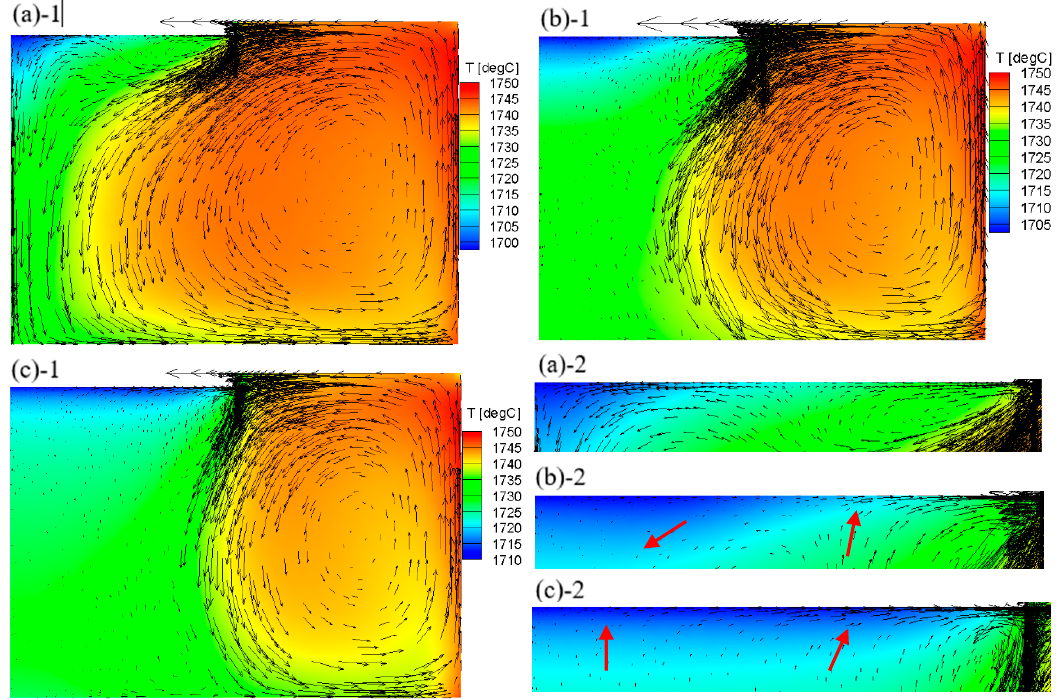
Figure 6. Variation in the temperature and flow field: ( a ), ( b ), ( c ) correspond to the rotational speed of 10 rpm, 170 rpm, 300 rpm, respectively; 1 and 2 correspond to the overall and partial speed,